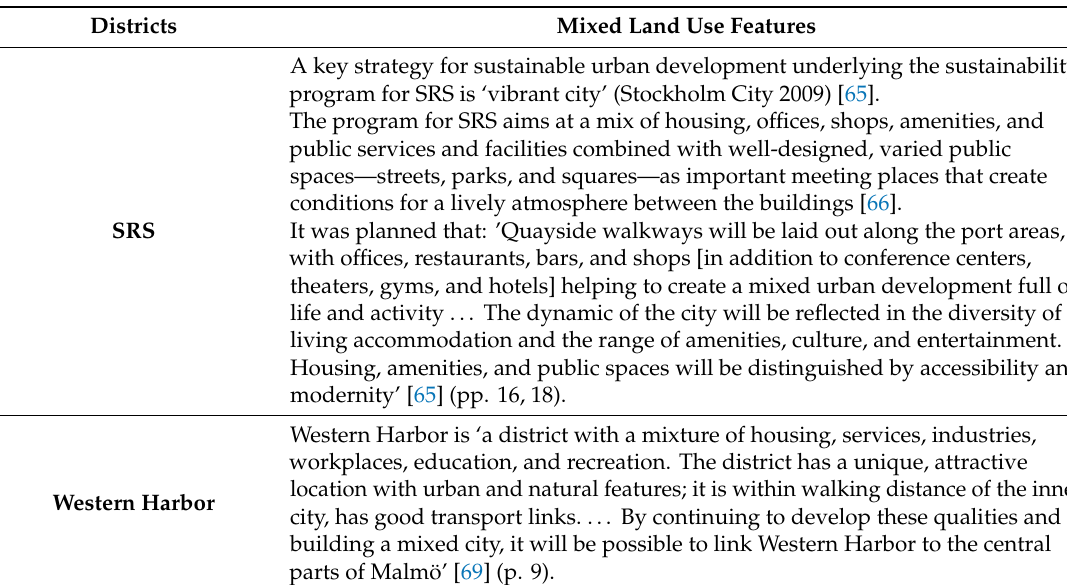
Table 7. Mixed land use features in SRS and Western Harbor.